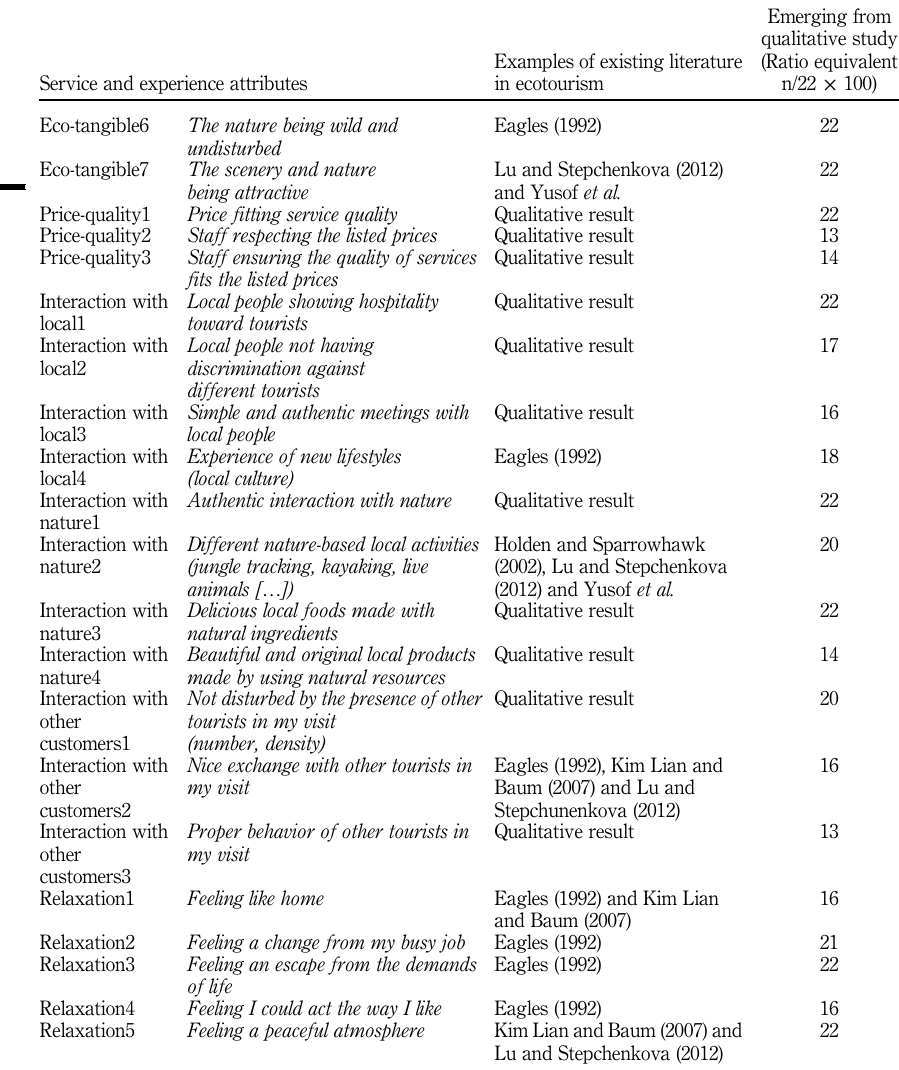
3.2.2 Quantitative data analysis . The data are then analyzed by means of an evaluation table, resulting in a categorization of the ecotourism service attributes for each respondent into five Kano categories (as illustrated in Figure 4). For instance, if the tourist